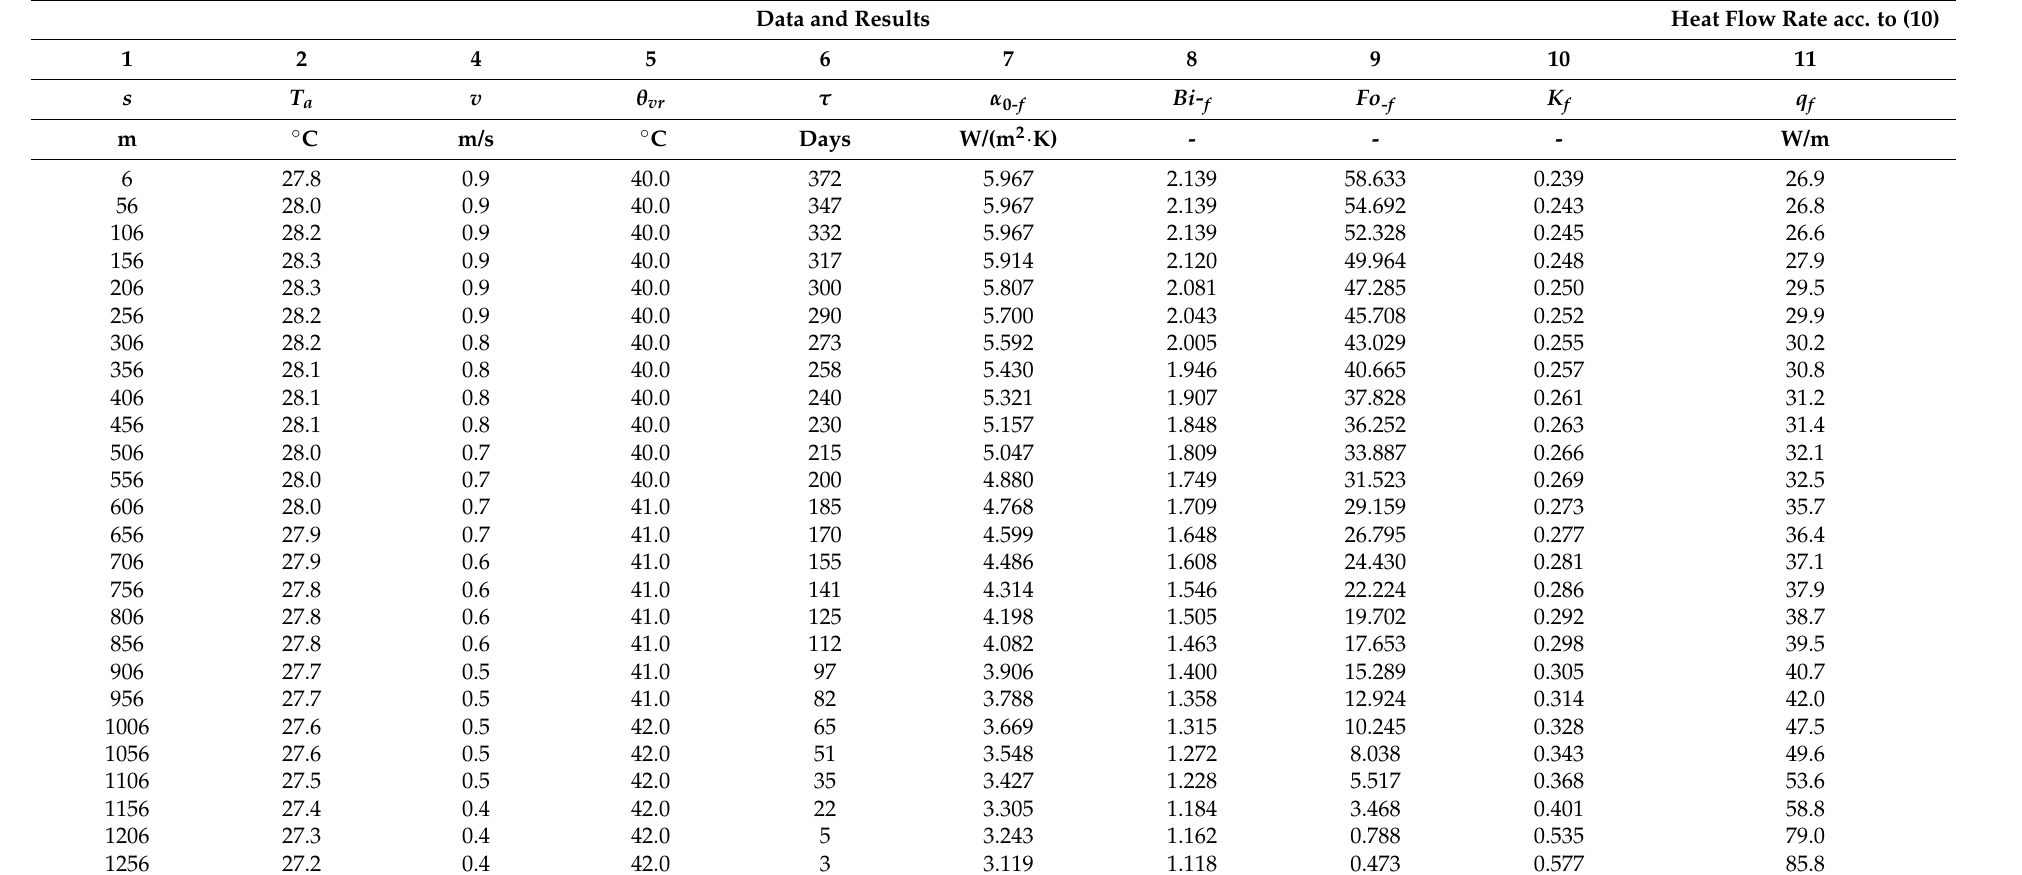
Table 2. Results of measurements and calculations of heat transfer from the rock mass through the floor of the heading. Data and